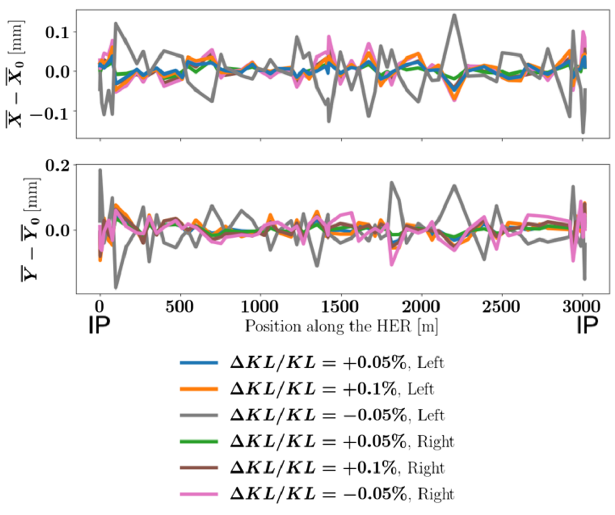
FIG. 14. The spectrum of the vertical position measurements from one BPM in HER during the K modulation measurements. The main frequency components of the turn by turn (TbT) data correspond to the horizontal and vertical tunes in the ring shown in tune units.